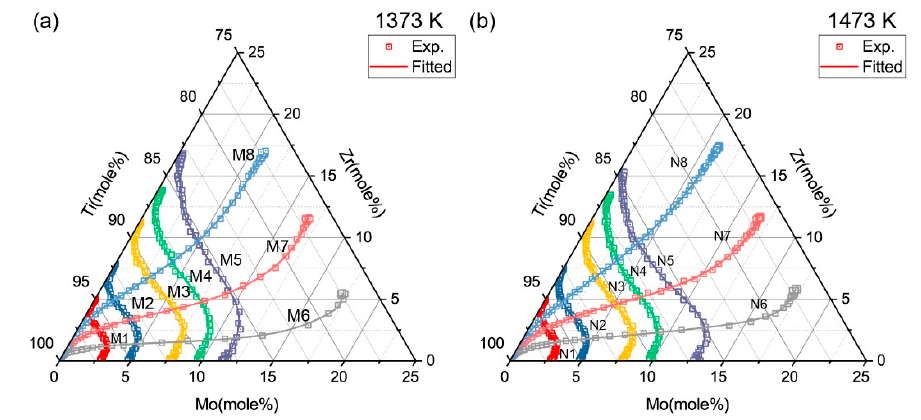
Figure 3. Diffusion paths of diffusion couples determined using electron probe micro-analysis (EPMA) after annealing process.